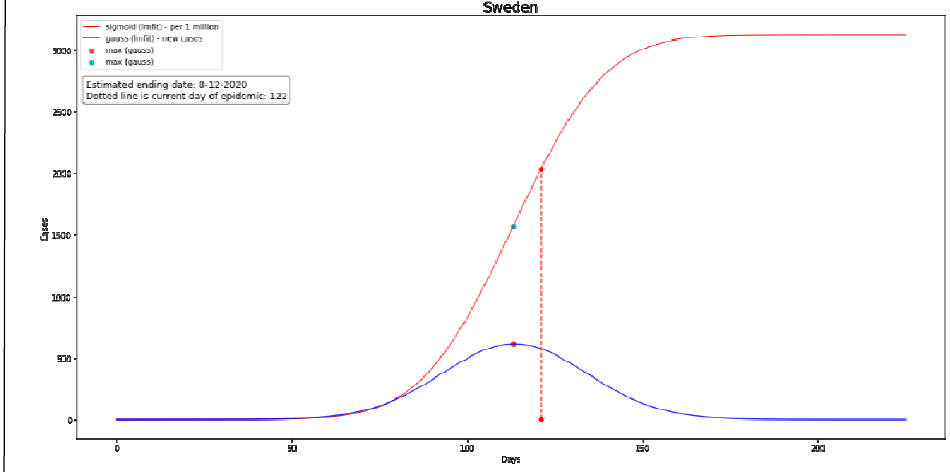
Figure 8 – COVID-19 Gaussian curve and S-curve for Sweden, on May 1 st , 2020 Рис . 8 – Кривая COVID-19 по модели кривой Гаусса и С - кривой , относящаяся к Швеции на 1 мая 2020 года